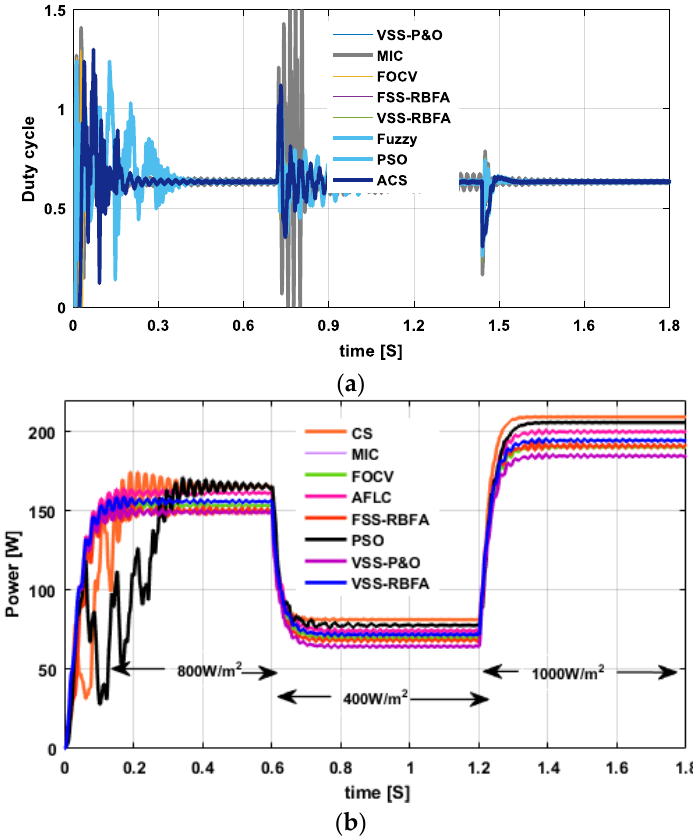
Figure 19. ( a ) Duty cycle of a SSBC by applying different MPPT techniques at (0.8, 0.4, and 1 kW/m 2 ) and ( b ) output power of a SSBC by applying different MPPT techniques at (0.8, 0.4, and 1 kW/m 2 ). Table 8. Performance results of a SSBC at different irradiation conditions (0.8, 0.4, and 1 kW/m 2 ). MPPT